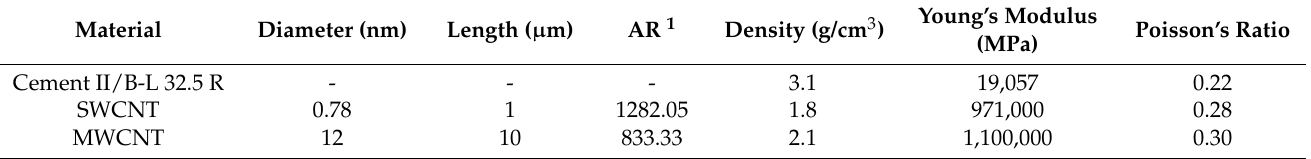
Table 1. Properties of the CNT